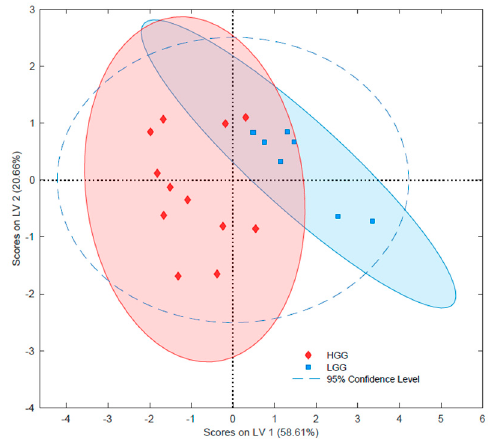
Figure 4. Principal least squares data analysis (PLS-DA) of gliomas with different grades. HGG—high grade glioma; LGG—low grade glioma.